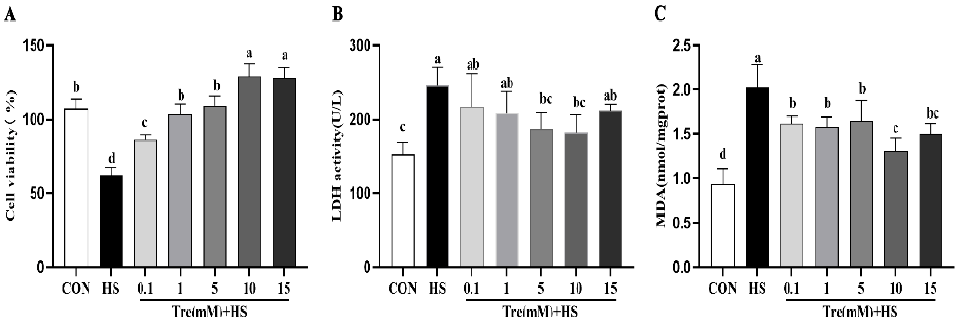
Figure 1. Effects of trehalose on cell viability ( A ), LDH activity ( B ), and MDA content ( C ) in heat ‐ stressed IPEC-J2 cells. IPEC-J2 cells were cultured at 37 ◦ C until the end of the experiment (control, CON); exposed to heat stress for 2 h (43 ◦ C, HS); or pretreated with different concentration of trehalose (0.1, 1, 5, 10, and 15 mM) at 37 °C for 4 h prior to heat stress exposure for 2 h. Data are shown as mean ± SD (n = 3). Means for variables that do not share a common letter differ significantly ( p < 0.05).